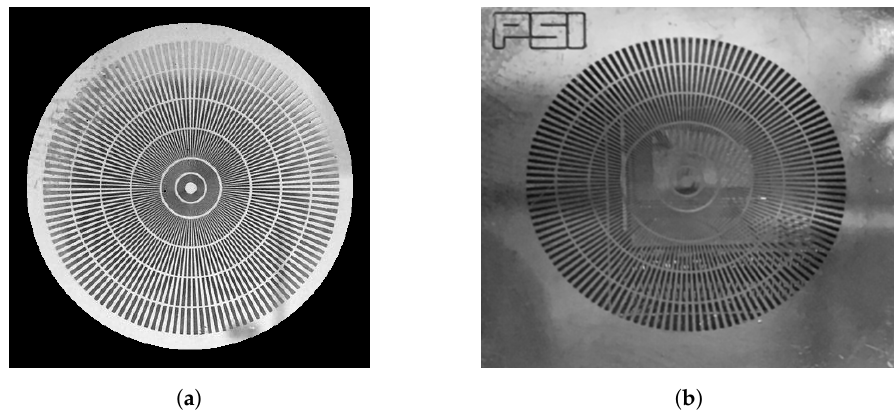
Figure 5. PSI Siemens star neutron imaging resolution test target photographs [24]. ( a ) Siemens star